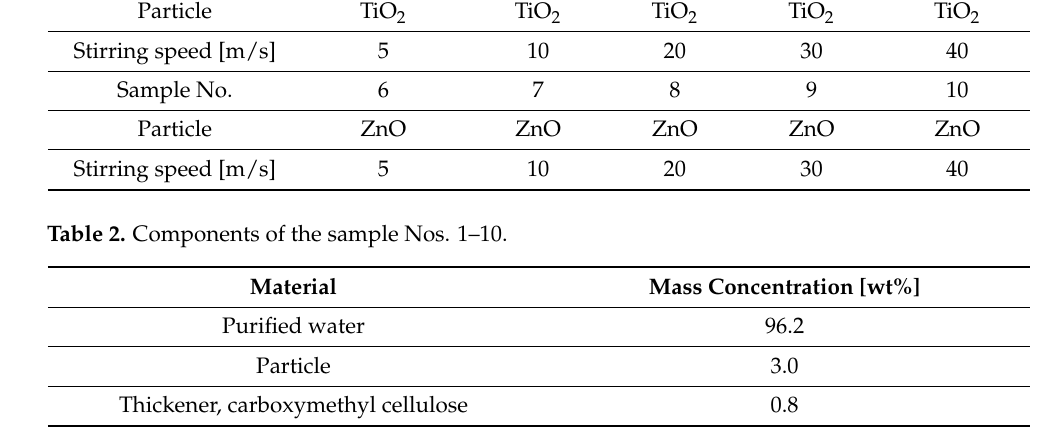
Table 1. Particle material and velocity of samples (Nos. 1–10) to change the scattering coefficient with stirring speed.